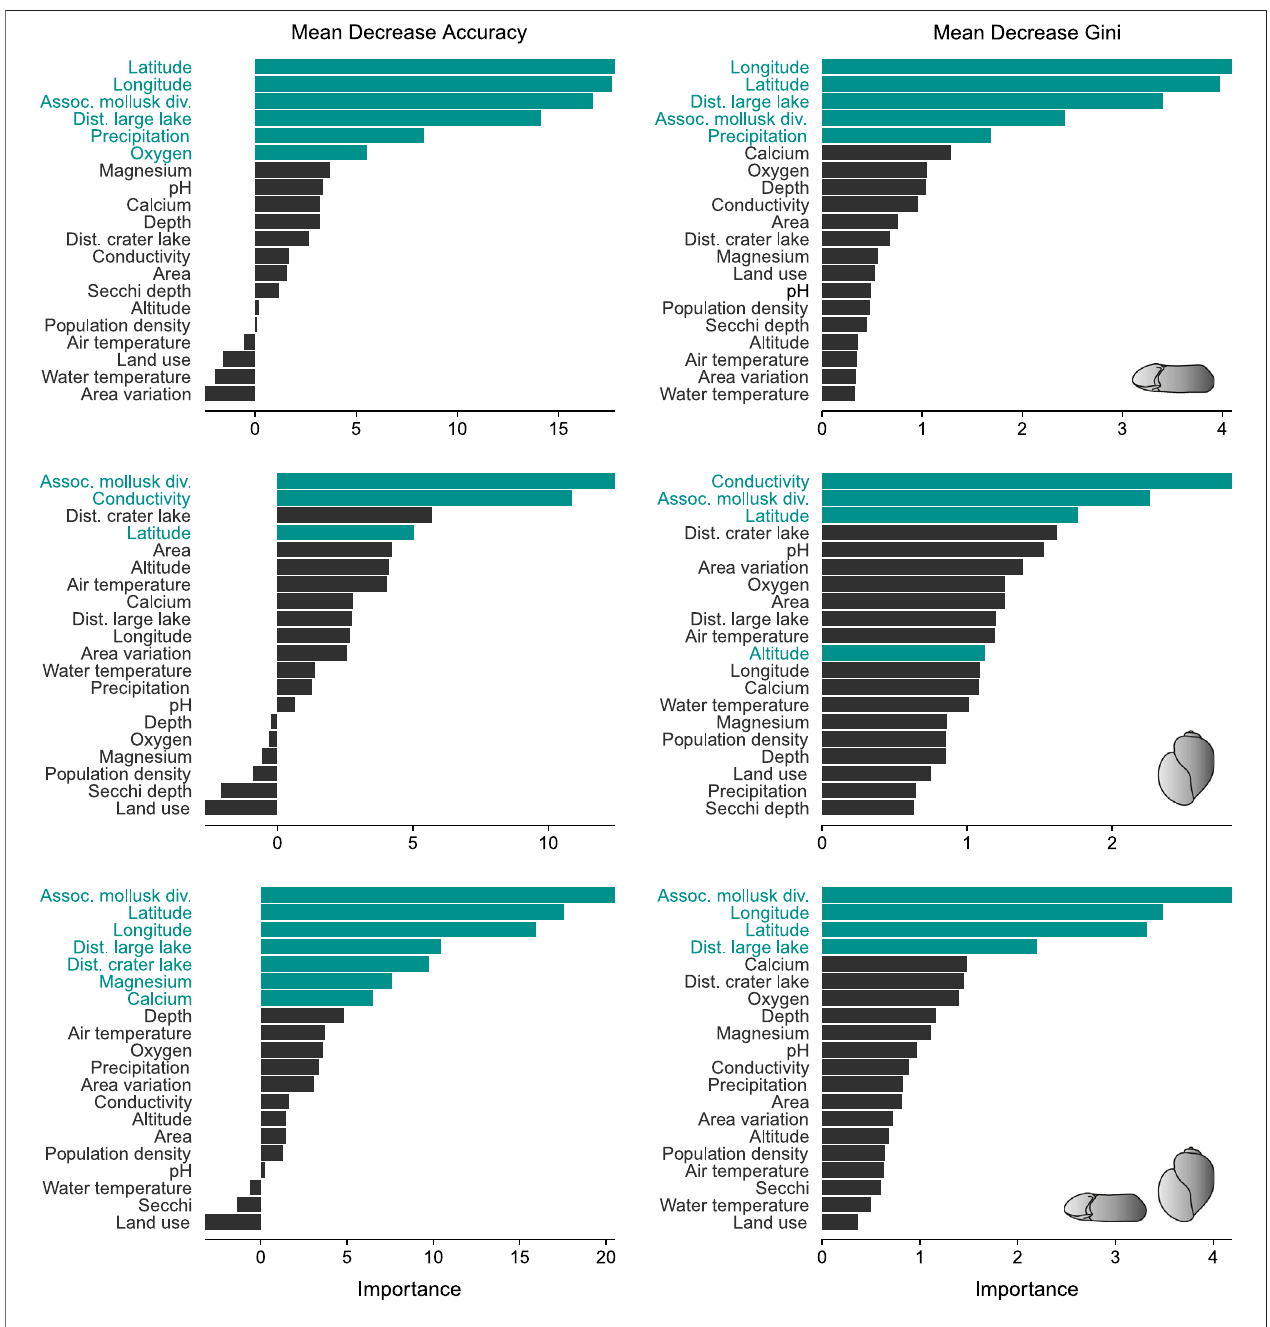
FIGURE 2 | Importance scores of predictor variables for Biomphalaria (upper panels), Bulinus (middle panels) and both genera combined (lower panels) for the complete dataset. The green bars indicate the signi fi cant predictors as determined via permutation tests. See Supplementary Figure S2 for the importance scores of the subset CLF